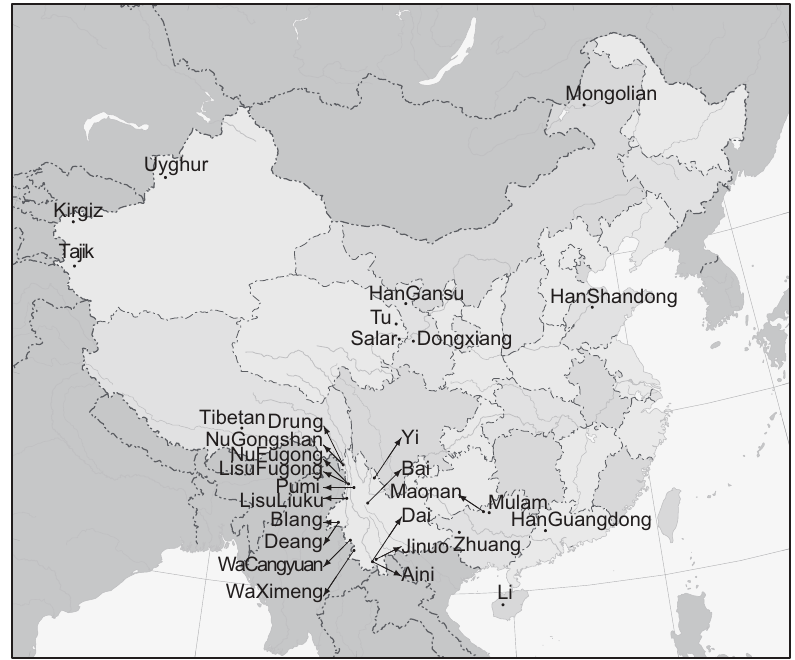
Figure 1. Geographical location of the 30 sampled populations. doi:10.1371/journal.pone.0009895.g001 PLoS ONE |